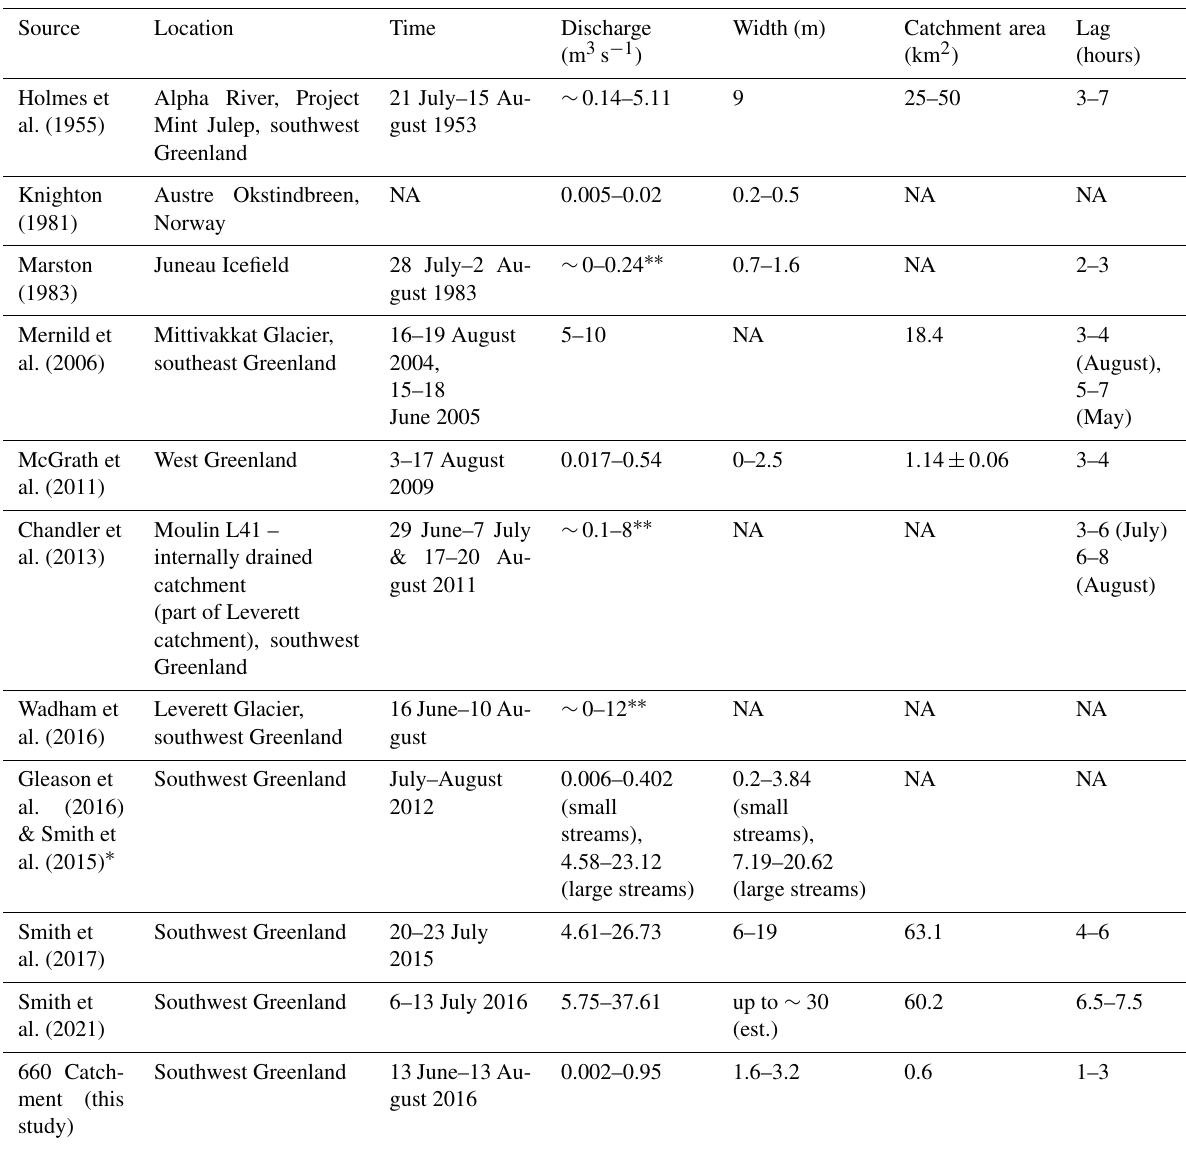
Table 1. Table of measured supraglacial streamflow, width, and catchment size from this and previous studies. “Width” denotes stream width, and “Lag” is the time of peak discharge after solar noon. NA – not